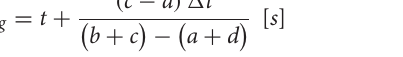
- follow-up times between the vehicles entering the circular roadway from the entry lanes, - gaps accepted and rejected by individual vehicle drivers from entry lanes, which then formed the basis for the designation of the critical gaps values for the vehicle drivers from entry lanes, - time gaps between the vehicles moving on the circular